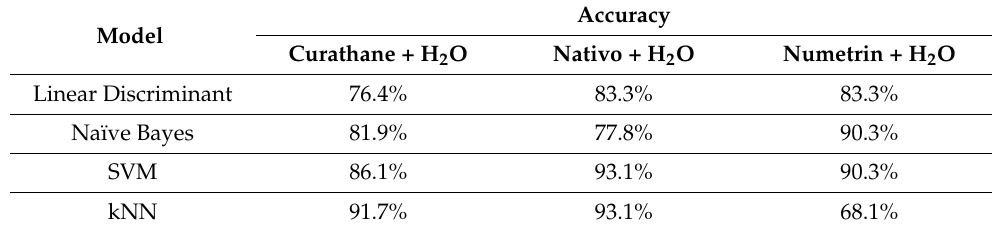
Table 2. Classification of pesticide types and distilled water samples using machine learning